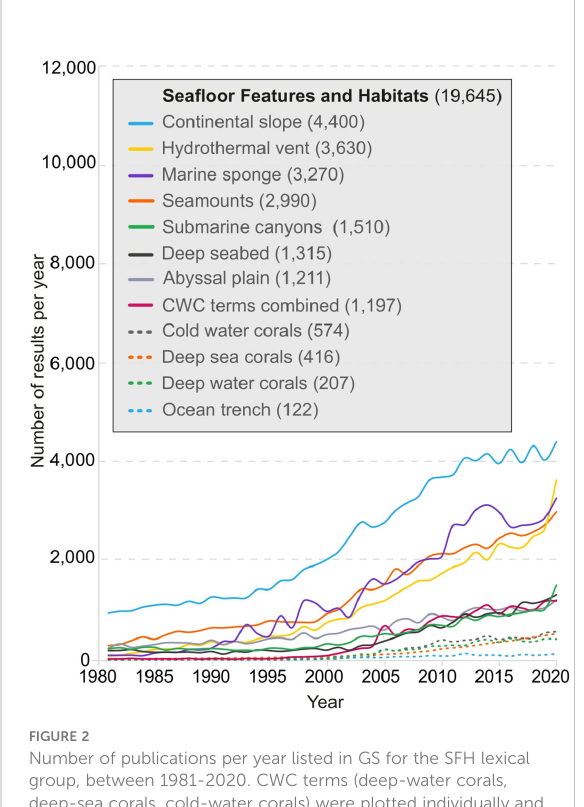
FIGURE 3 Number of publications listed per year in GS for the MLI lexical group, between